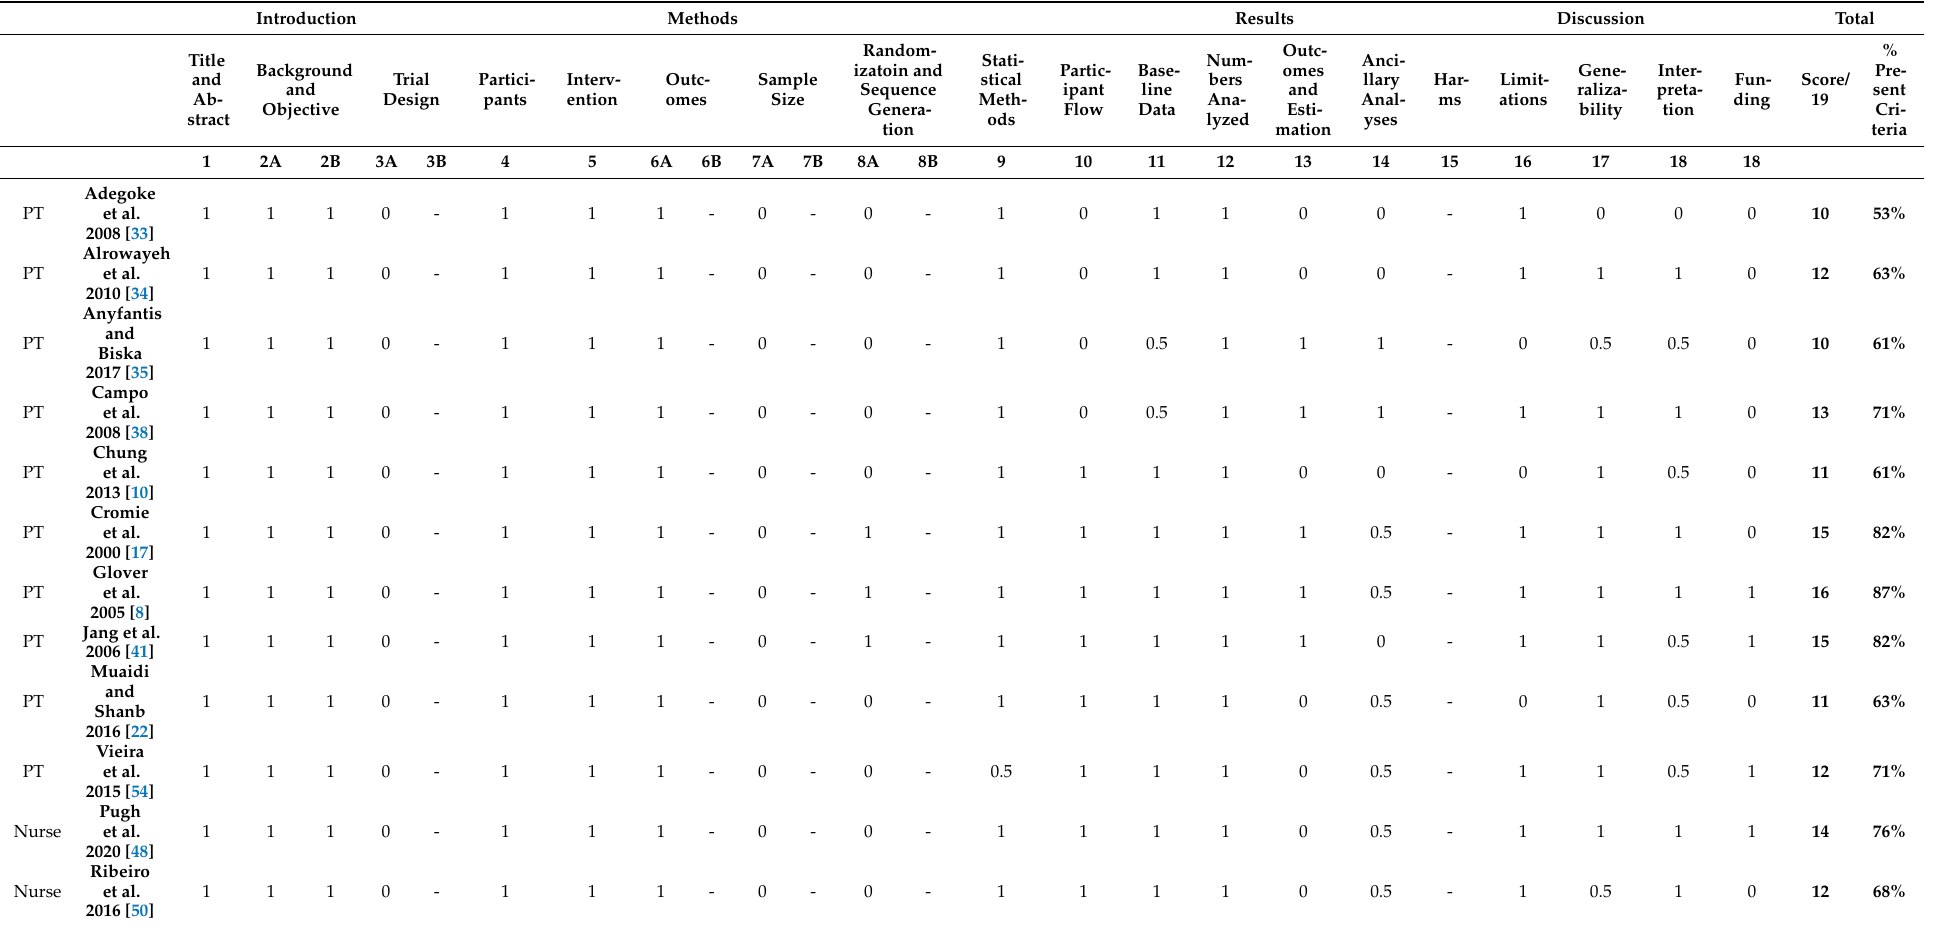
Table A1. Detailed quality appraisal of the 36 articles included in review using the modified CONSORT 2010 checklist